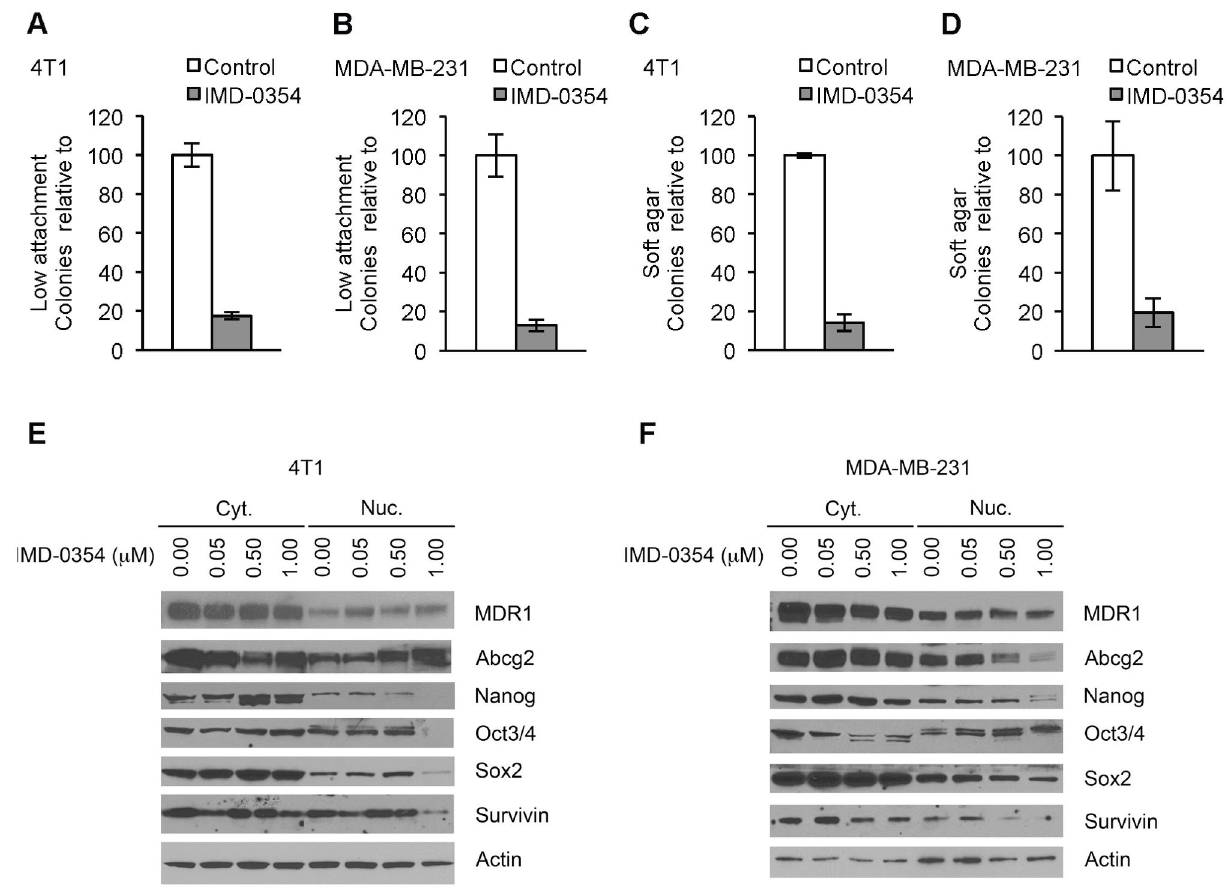
Figure 4. Effects of IMD-0354 on CSCs. Number of colony formation in low attachment plates of 4T1 (A) and MDA-MB-231 (B) treated with 1 µM IMD-0354. Number of colony formation in soft agar of 4T1 (C) and MDA-MB-231 (D) treated with 1 µM IMD-0354. Western blot of CSCs gene expression of cytosolic and nuclear extract from 4T1 (F) and MDA-MB-231 (G) cells treated with IMD-0354. Data are shown as mean ±